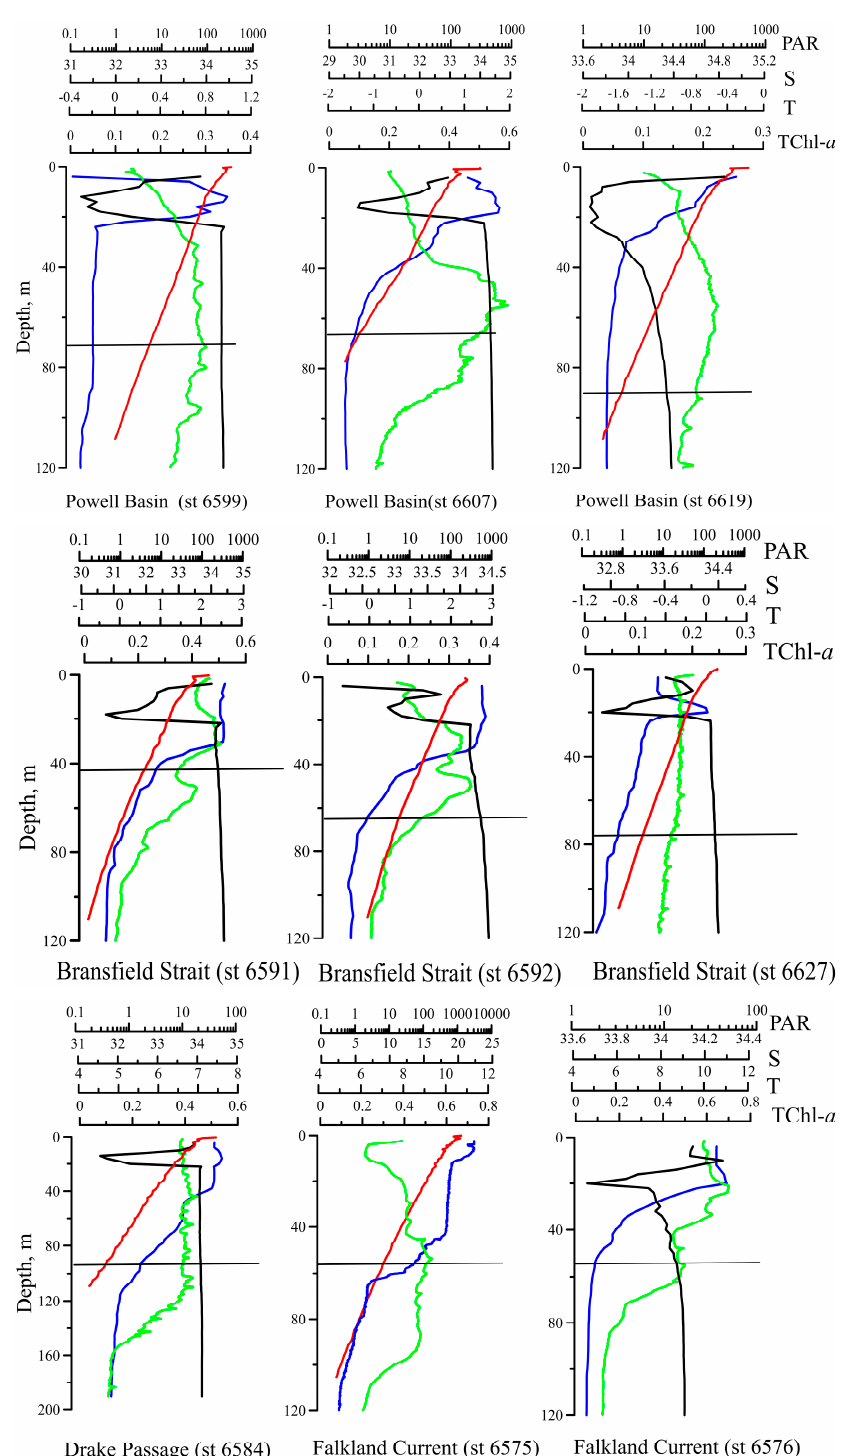
Figure 2. Vertical profiles of temperature (T, °C, blue line), salinity (S, ‰, black line), the fluorescence of chlorophyll a (TChl- a , mg m − 3 , green line), and photosynthetic available radiance (PAR, μ E m − 2 s − 1 , red line) at some stations in all regions investigated in Atlantic sector of the Southern Ocean. The horizontal black line denotes the depth of 1% PAR.